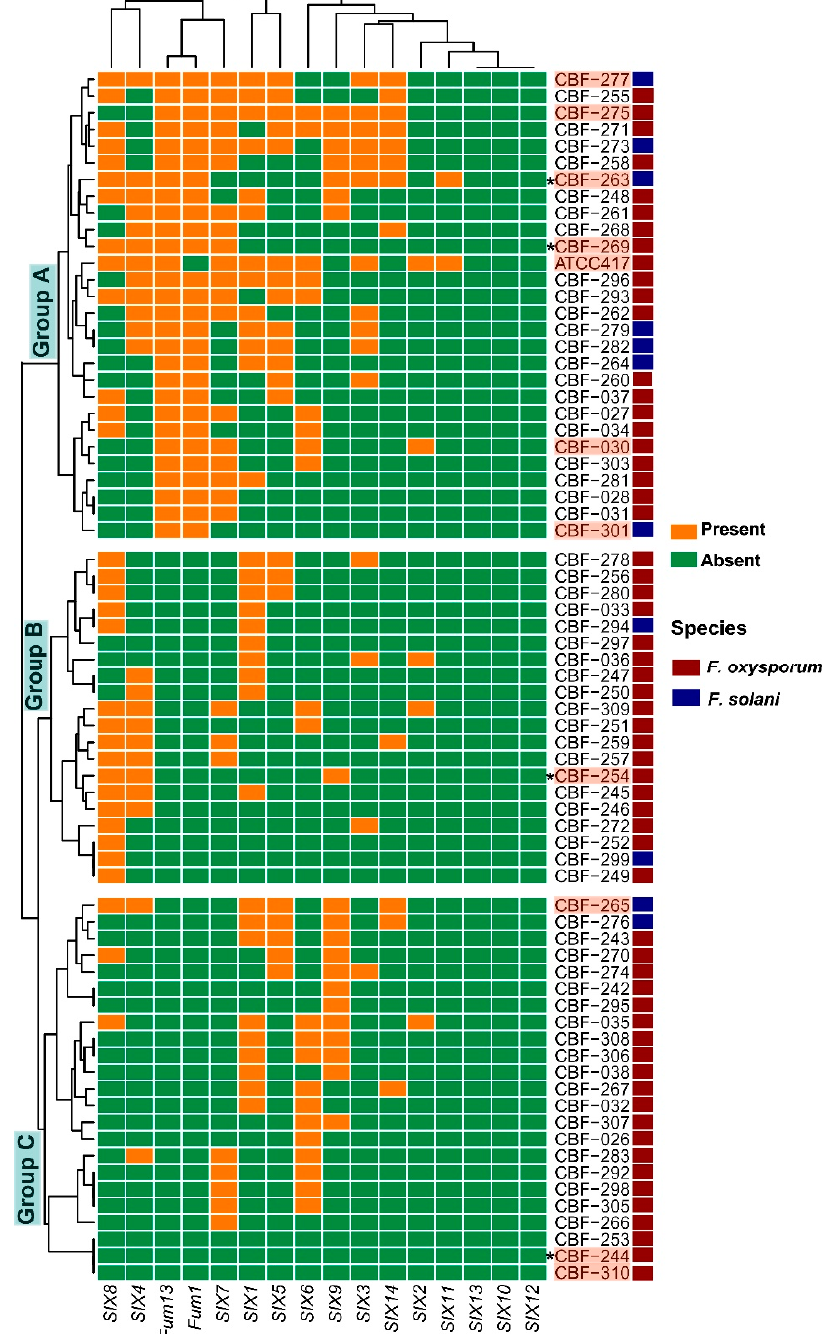
Figure 2. Binary heatmap of SIX and Fum genes (presence/absence) identified in the Fusarium isolates. The binary distance matrix was used to perform a hierarchical clustering with ward.D2 method. Presence, orange; absence, green. The Fusarium isolates used for pathogenicity test are highlighted. Fusarium specie are indicated by red ( F. oxysporum ) and blue squares ( F. solani ). The asterisks ( * ) indicate Fusarium isolates from healthy coffee seedlings.